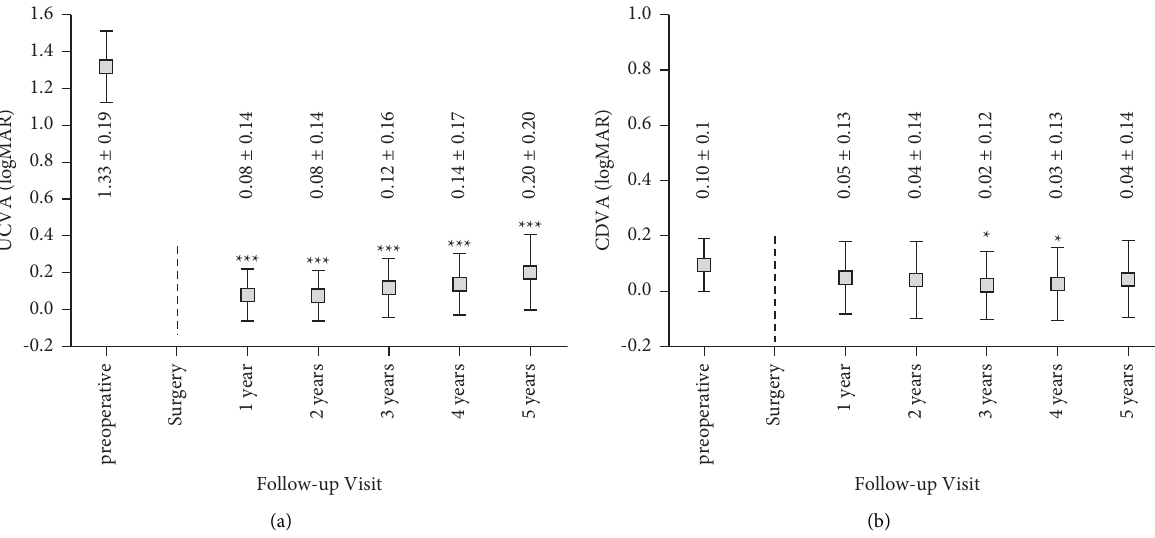
Figure 2: (a) UCVA pre- and up to 5 years after pIOL implantation. Values are presented as mean ± SD ( ∗∗∗ p < 0 . 0001). (b) CDVA pre- and up to 5 years postoperatively. Values are presented as mean ± SD ( ∗ p < 0 . 01).